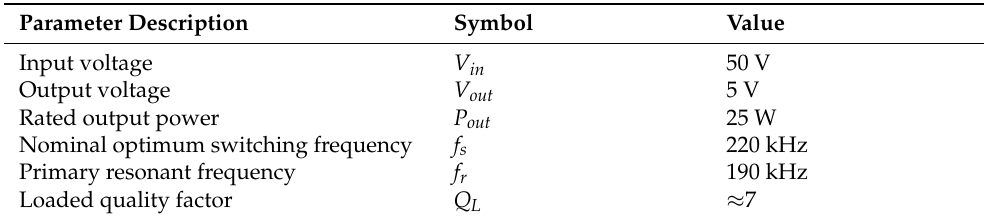
Table 2. Converter specifications at the optimum operating